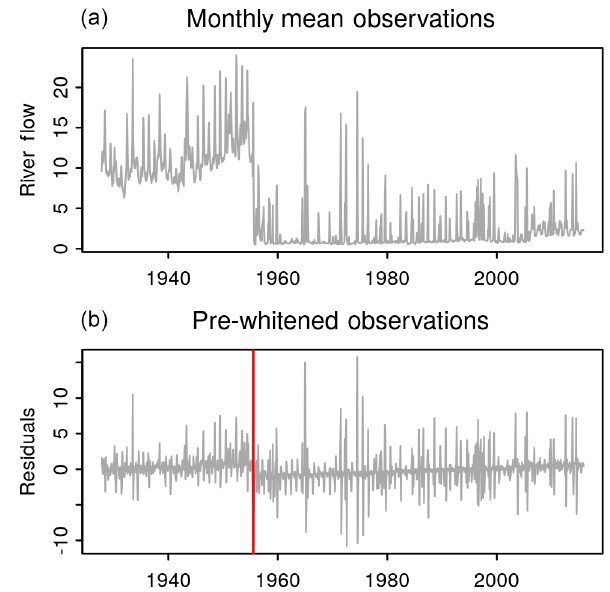
Figure 5. Homogeneity assessment of monthly mean flow of the North Umpqua River, US. (a) Monthly mean observations. (b) Pre- whitened observations together with the time step at which the stan- dard normal homogeneity test, the Buishand range test and the Pet- titt test identified a breakpoint at the 0.01 significance